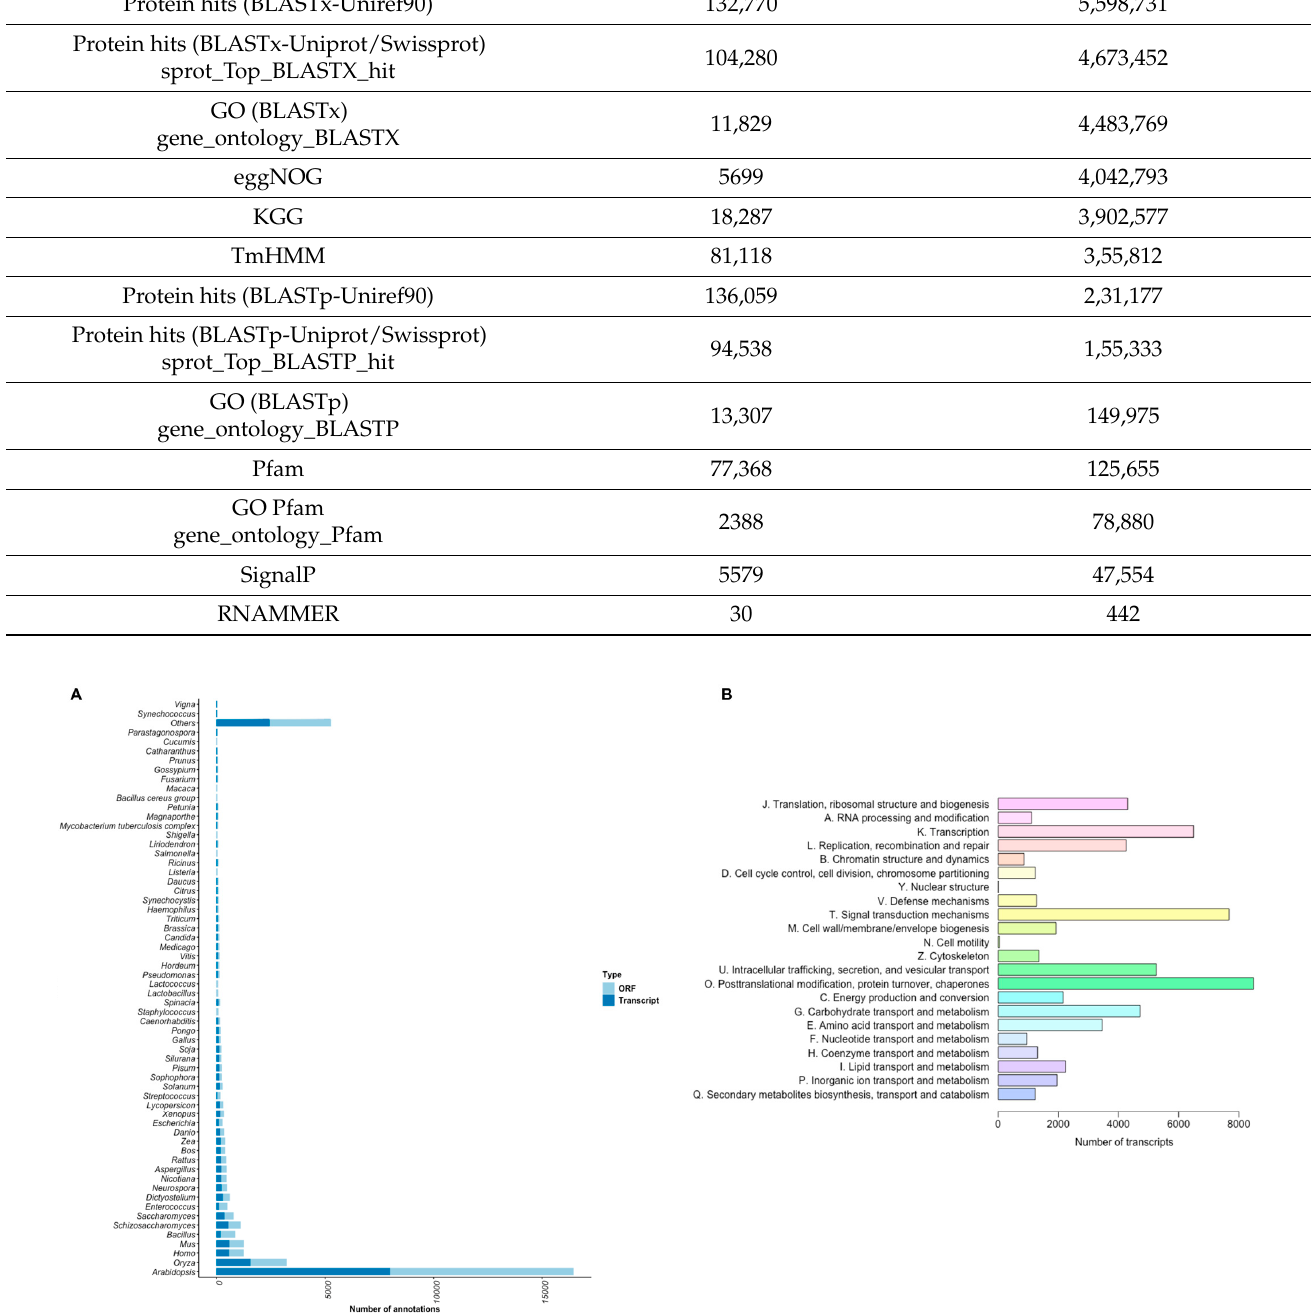
Figure 2. Functional annotation using BLASTx, ( A ) Top-hit genus taxonomic distribution (ORF and transcripts). ( B ) Number of transcripts matching with the eggNOG database. Different color represents the pathways categorized in information storage and processing (J, A, K, L, B), cellular processes and signaling (D, Y, V, T, M, N, Z, U, O), and metabolism (C, G, E, F, H, I, P,